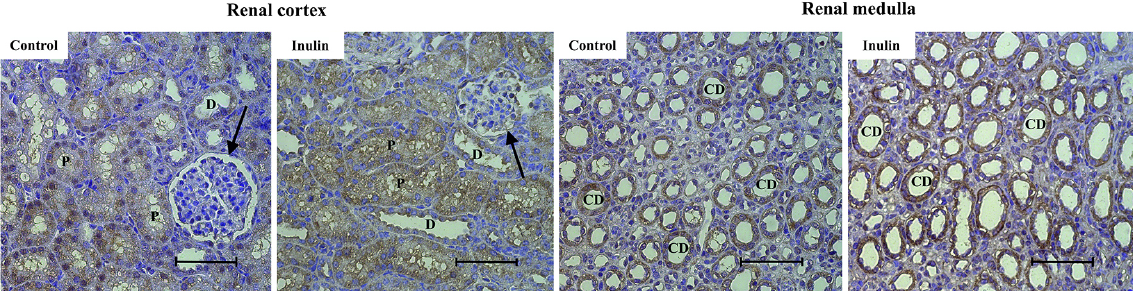
Figure 1. Immunolocalization and immunoexpression of TRPM6 in the renal cortex and medulla of the control group and pigs fed a diet supplemented with 2% inulin. The letters and markers on microphotography indicate the following: D – distal tubules; P – proximal tubules; black arrow – glomerulus; CD – collecting ducts. Bar = 50µm.